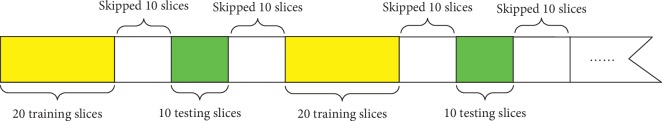
Schematic diagram of data preparation. The yellow rectangular blocks represent the training data, the green rectangular blocks represent the test data, and the white rectangular blocks represent the skipped slices.